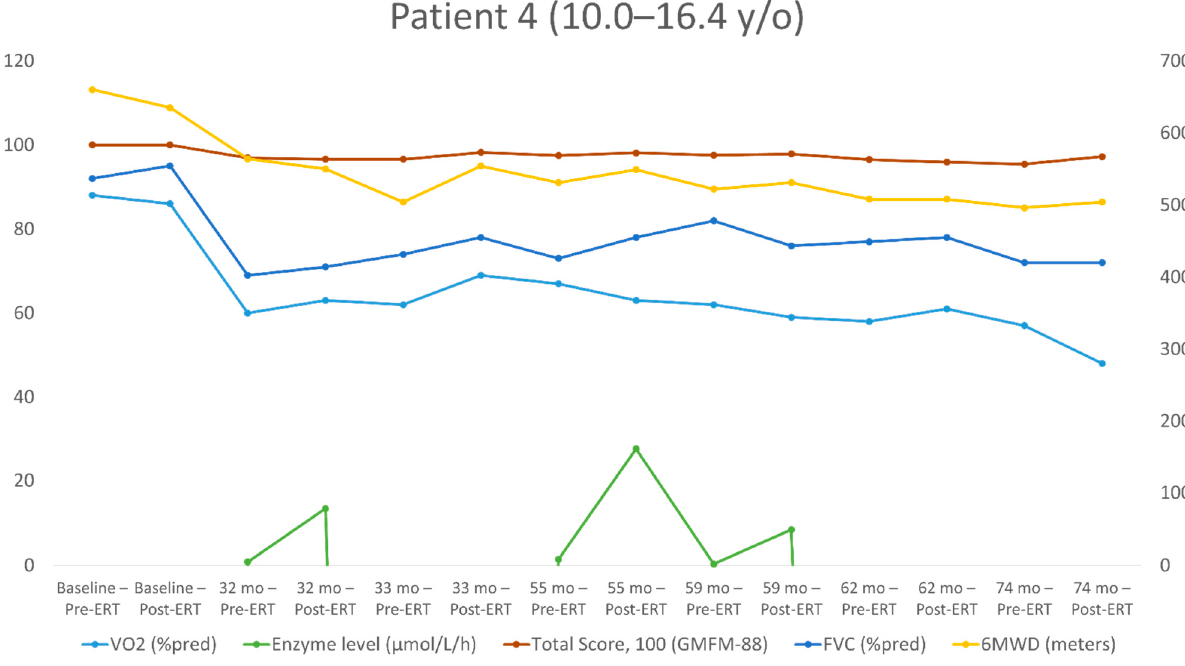
Figure 4. Long-term follow-up of the study parameters (patient 4). y/o = year old, VO 2 = peak oxygen uptake at the peak of exercise; %pred = % of the predicted value; FVC = forced vital capacity; 6MWD = 6-min walking distance.